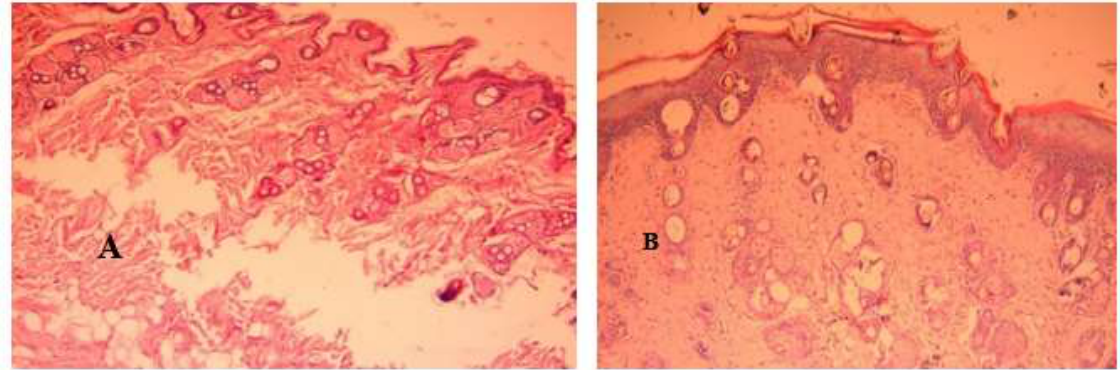
Figure 6. Histopathological changes in topically AD induced group (B) in comparison with Tacrolimus treated group (A) (10x): ordinary Hematoxylin and eosin stain.